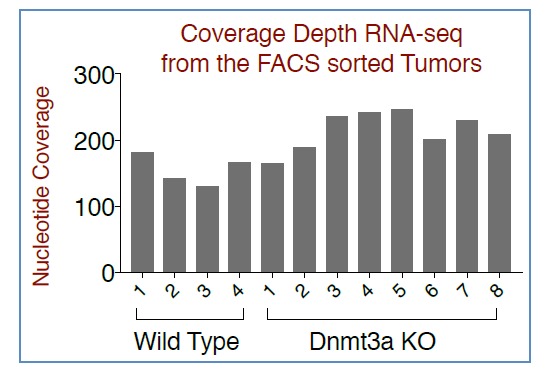
DOI:
http://dx.doi.org/10.7554/eLife.21697.035